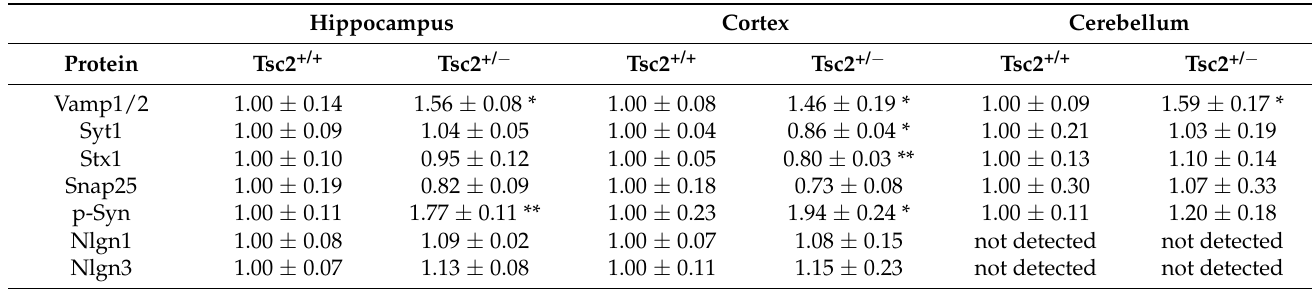
Table 2. The effect of Tsc2 haploinsufficiency on levels of synaptic proteins—densitometric analysis. Hippocampus Cortex Cerebellum